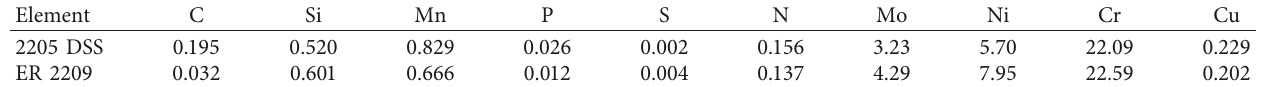
Table 1: Compositions of 2205 DSS and ER 2209 (wt.%).